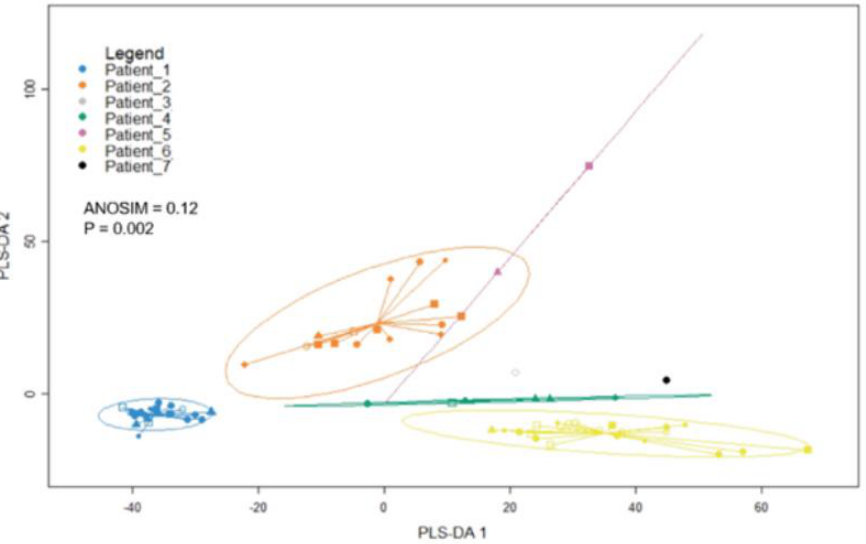
Figure 7. Sparse Partial Least Squares Discriminant Analysis of Patient-Derived CTCs: analysis of similarity (ANOSIM) demonstrates low interpatient heterogeneity (melanoma CTCs isolated from different patients are relatively similar to one another), but variable intrapatient heterogeneity.